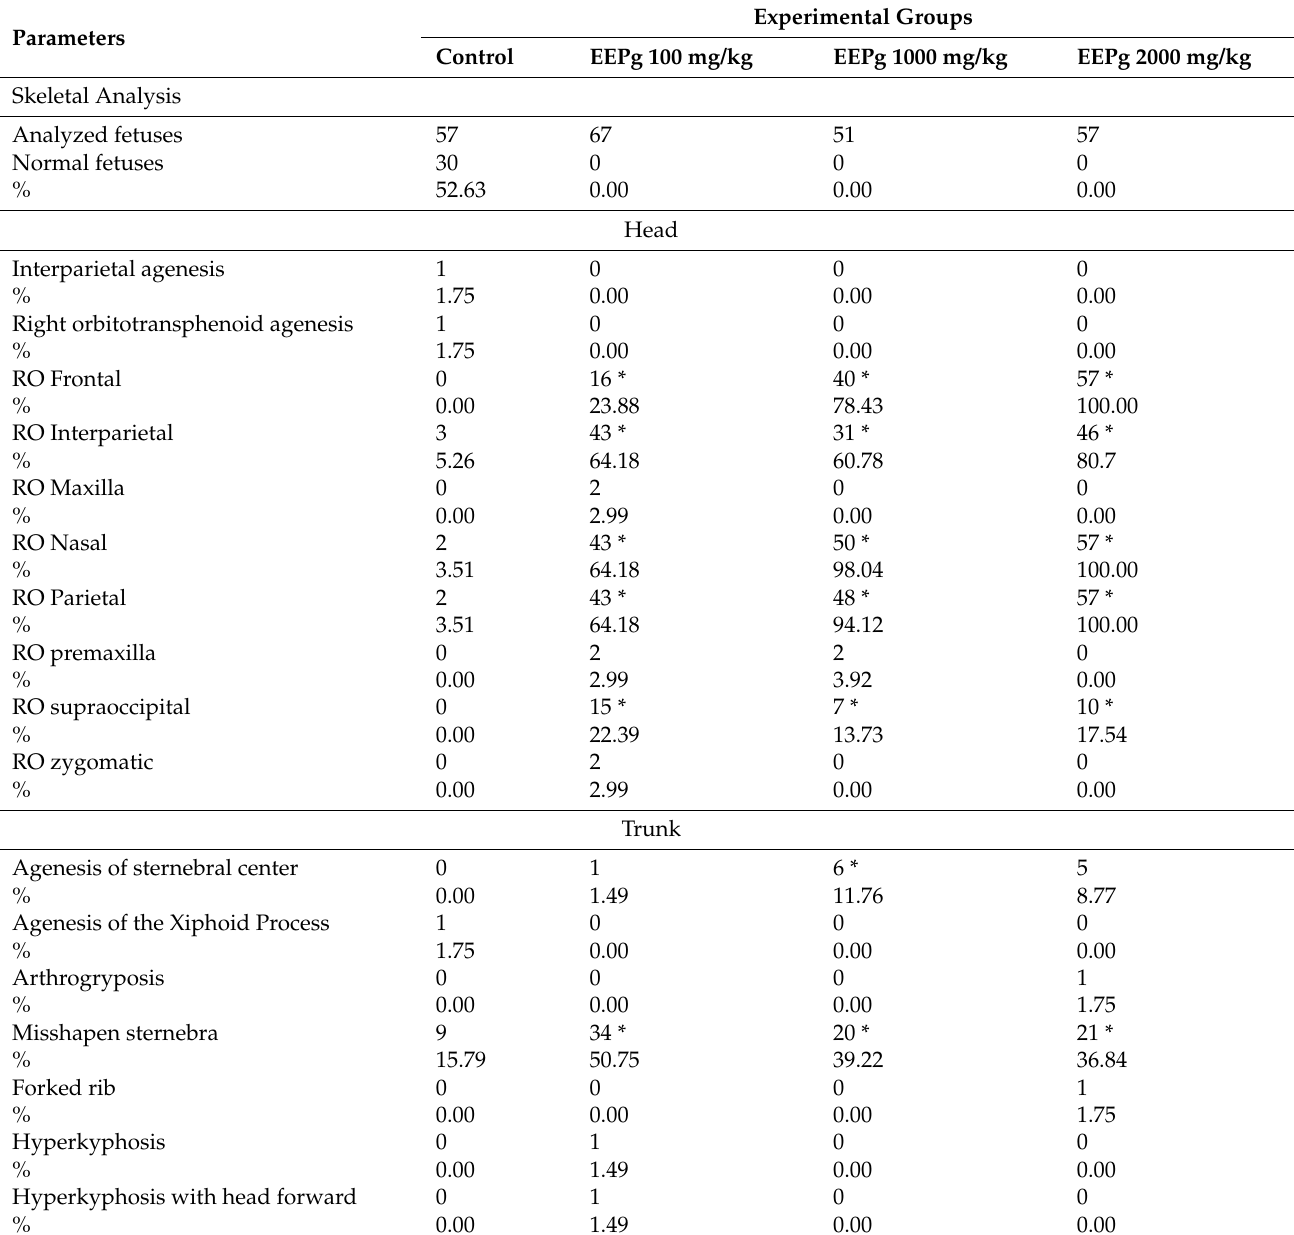
Table 7. Absolute number and percentage of skeletal malformations found in the offspring of females treated with the ethanolic extract of P. glabratum